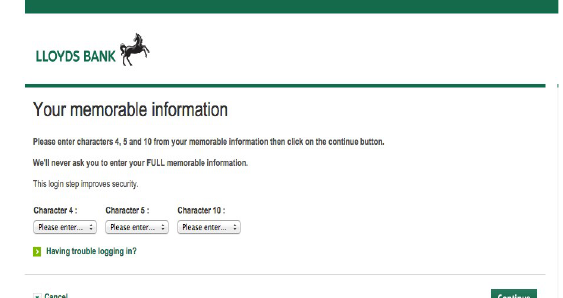
Figure 2-2: Memorable